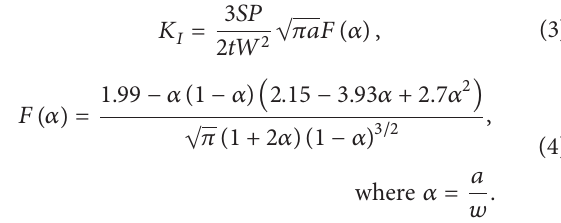
a material property which is independent of the applied loads and the geometry configuration of the body.